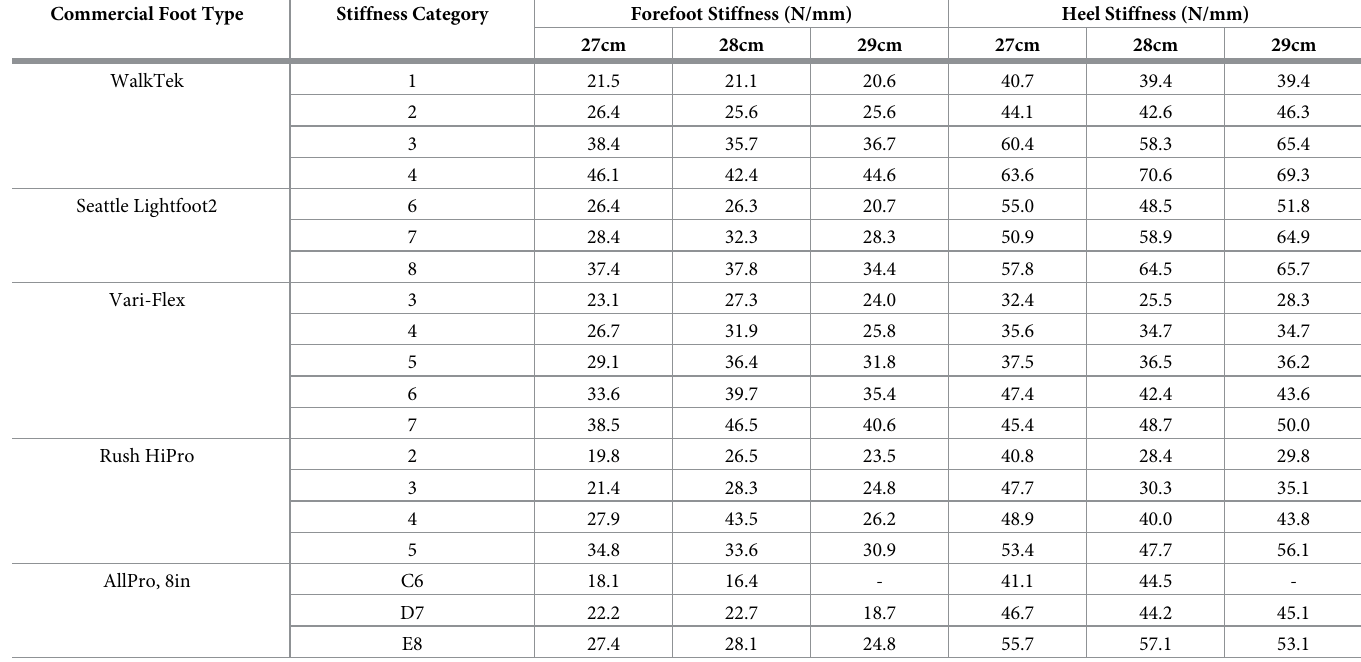
Table 2. Calculated linear stiffness properties (N/mm) by manufacturer-defined stiffness categories.